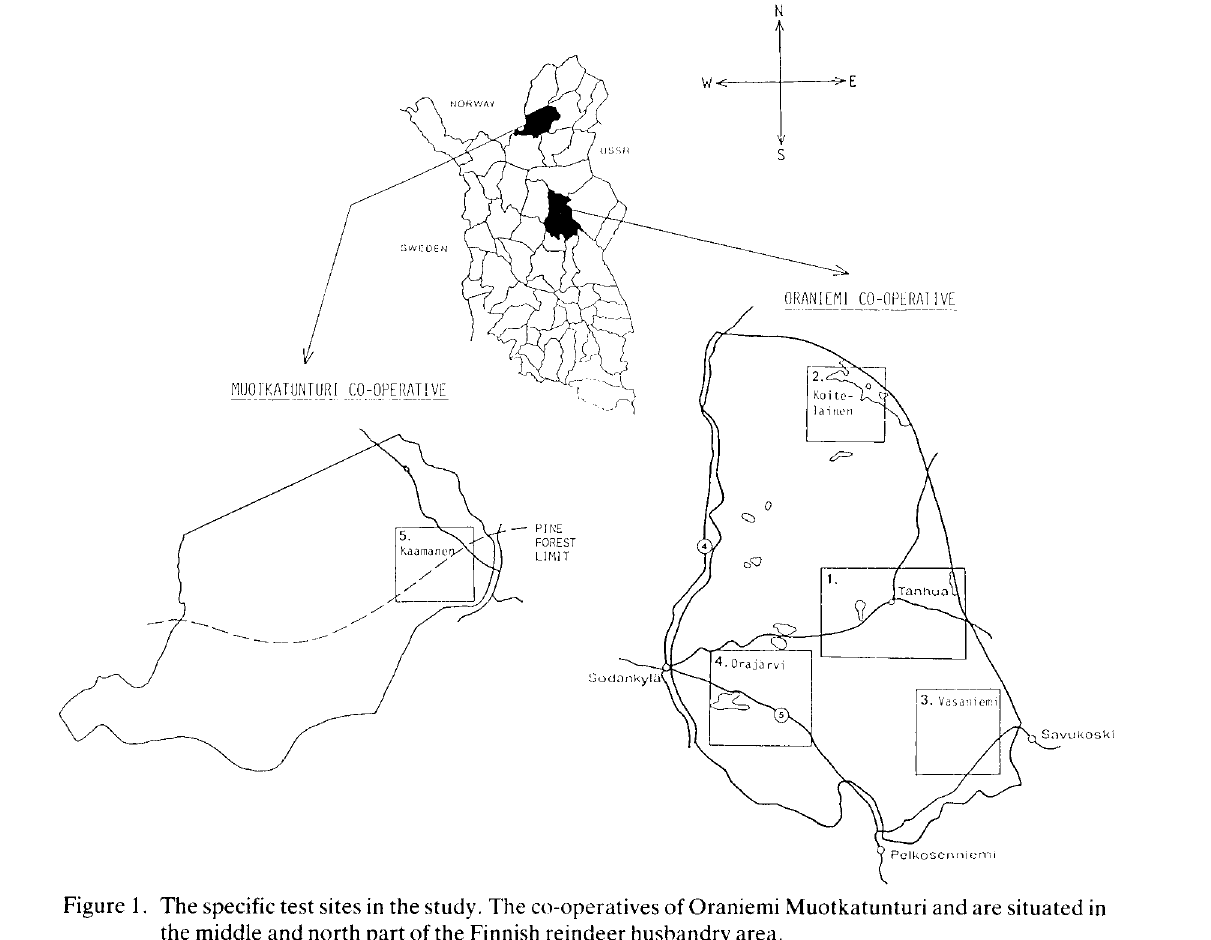
Figure 1. The specific test sites in the study. The co-operatives of Oraniemi Muotkatunturi and are situated in the middle and north part of the Finnish reindeer husbandry